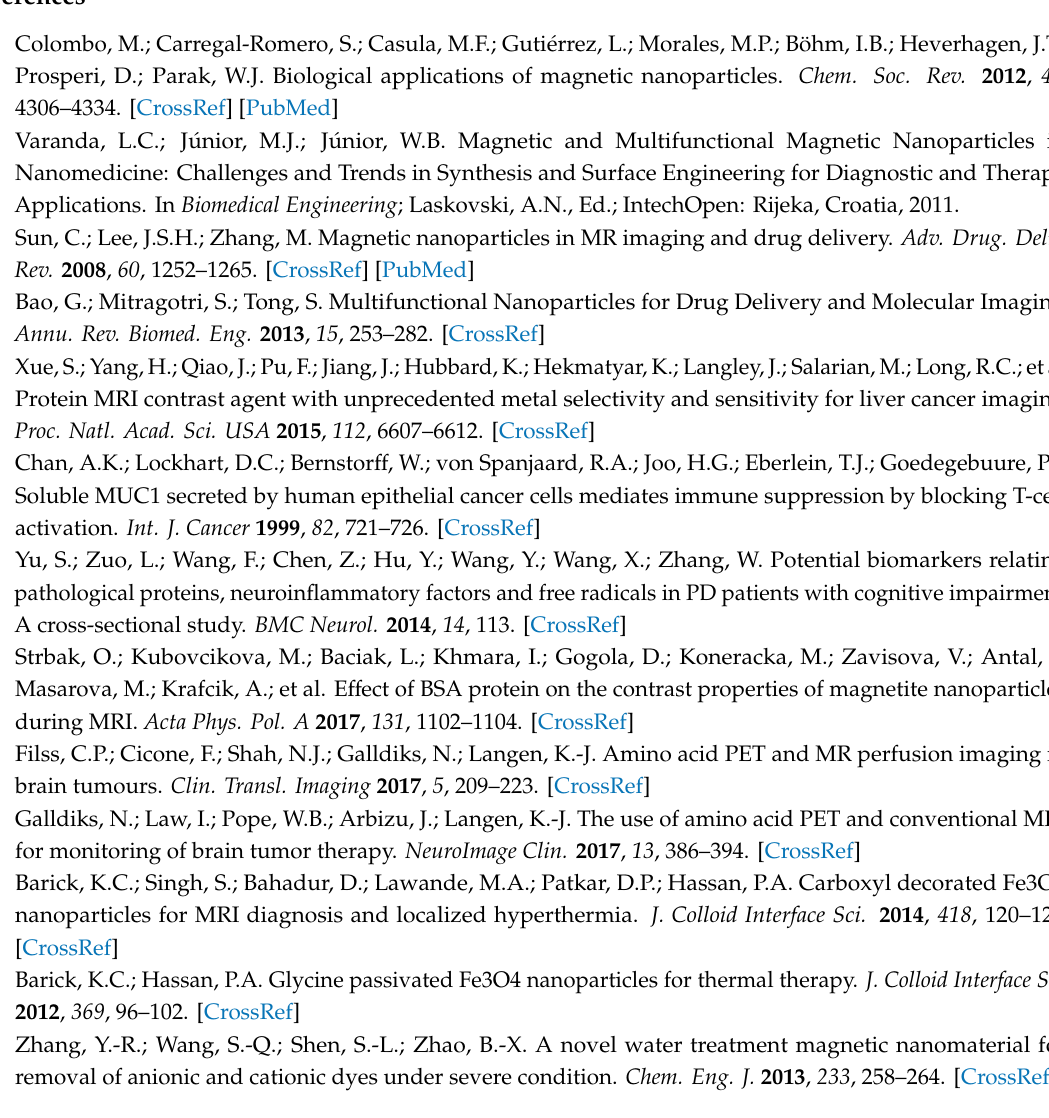
Figure S2c: Relaxivity r 2 * determination of the Lys-MNPs complex. Figure S3a: Relaxivity r 1 determination of the Gly-MNPs complex. Figure S3b: Relaxivity r 2 determination of the Gly-MNPs complex. Figure S3c: Relaxivity r 2 * determination of the Gly-MNPs complex. Figure S4a: Relaxivity r 1 determination of the Trp-MNPs complex. Figure S4b: Relaxivity r 2 determination of the Trp-MNPs complex. Figure S4c: Relaxivity r 2 * determination of the Trp-MNPs complex. Figure S5a: Relaxivity r 1 determination of the Lys without MNPs. Figure S5b: Relaxivity r 2 determination of the Lys without MNPs. Figure S6a: Relaxivity r 1 determination of the Gly without MNPs. Figure S6b: Relaxivity r 2 determination of the Gly without MNPs. Figure S7a: Relaxivity r 1 determination of the Trp without MNPs. Figure S7b: Relaxivity r 2 determination of the Trp without